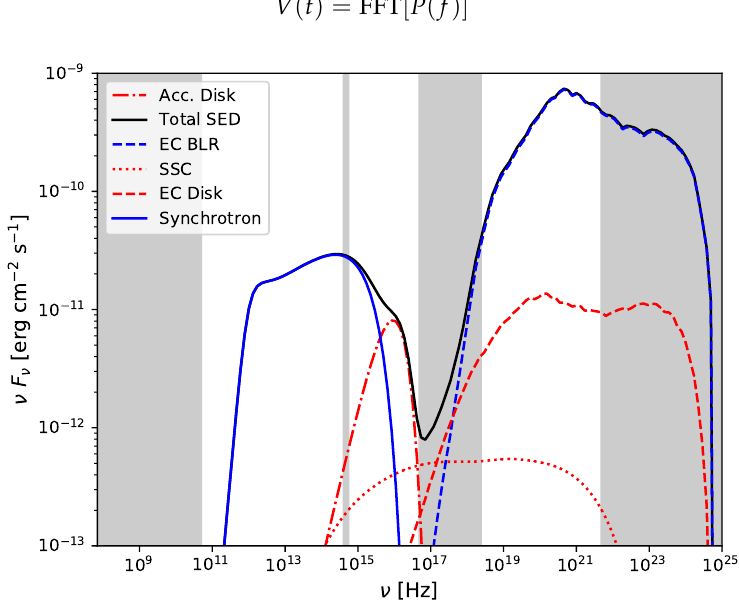
Figure 1. Steady-state Spectral Energy Distribution (SED) for the parameters in Table 1. The double-humped non-thermal emission is clearly visible. The shaded areas indicate the energy ranges for radio optical, X-rays, and γ -rays used in the model to produce light curves.